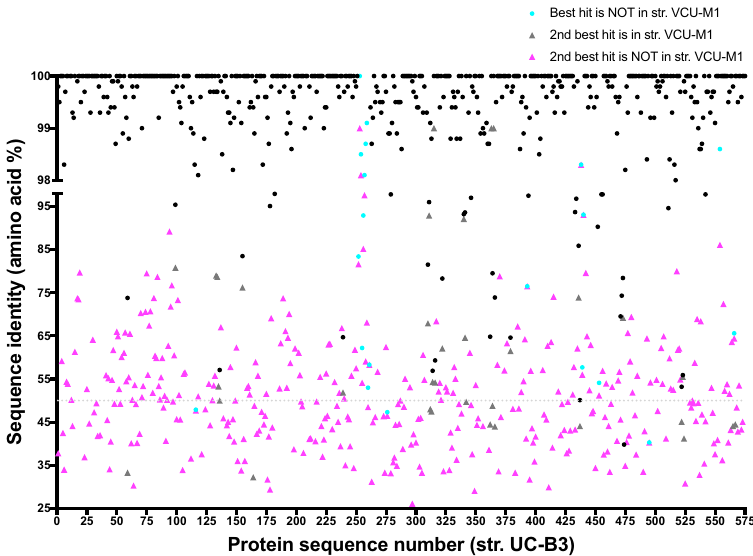
Figure 2. Phylogenetically distinct from other Mollicutes, Ca . M. girerdii strains are distinguished from each other by a small set of variable features. Displayed are the highest identity database hits for Ca . M. girerdii strain UC-B3 proteins. Sequences (n = 574) were queried against the UniRef100 database (downloaded December 2015) using USEARCH in local alignment mode with the settings described in the Supplementary Methods. Under these search conditions, 8 sequences had no hit (not plotted), 176 had only 1 hit (plotted as ‘best’), and 390 had at least 2 hits (plotted as ‘best’ and ‘2 nd best’ by identity). Also indicated is whether or not the hit was from closely related strain VCU-M1. USEARCH is most effective at protein identities ≥ 50% (dotted line). On the x-axis, sequences are numbered in order of appearance in the UC-B3